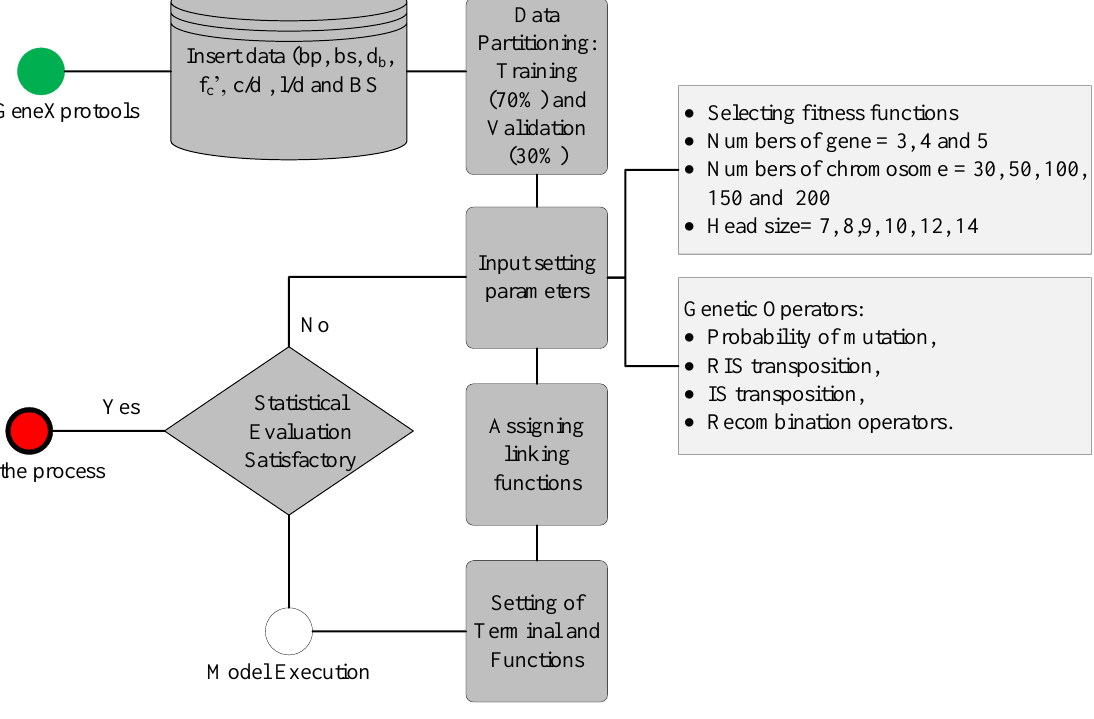
Figure 4. Flowchart of GEP modelling.